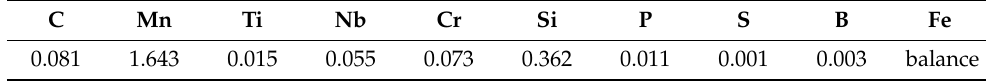
Table 1. The Ductibor ® 1000-AS chemical composition (unit: wt.%). C Mn Ti Nb Cr Si P S